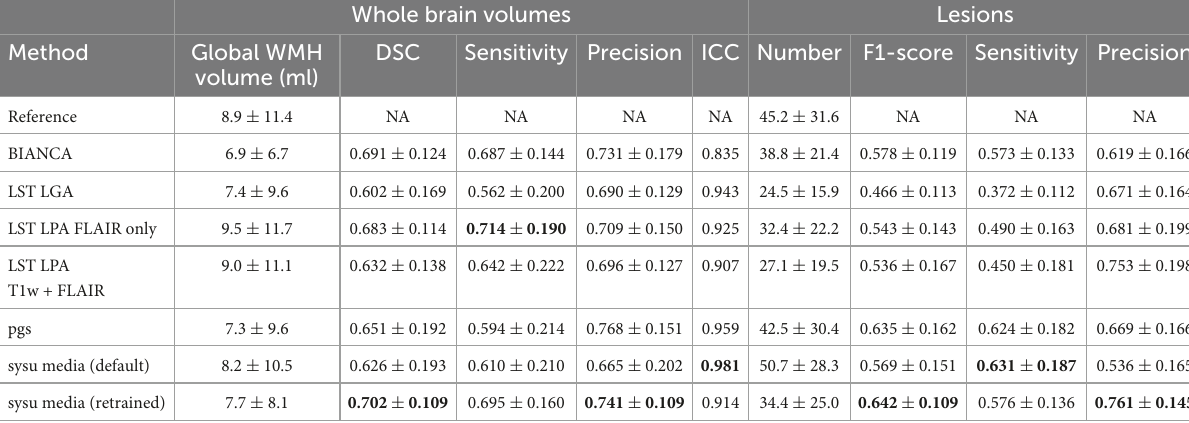
TABLE 3 Performances of all algorithms compared to the reference segmentation at volume- and lesion-